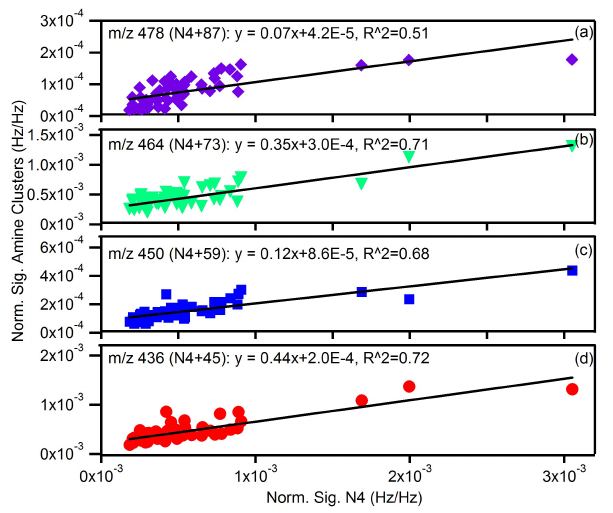
Fig. 5. Correlation of individual amine concentration with sulfuric acid tetramer (N4) (normalized) from measurements in Fig. 4.